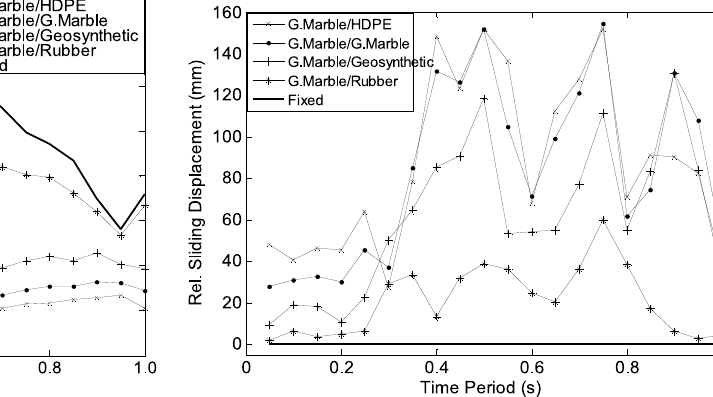
Fig. 11. Displacement spectra for fi xed and different sliding inter- faces for spectrum compatible ground